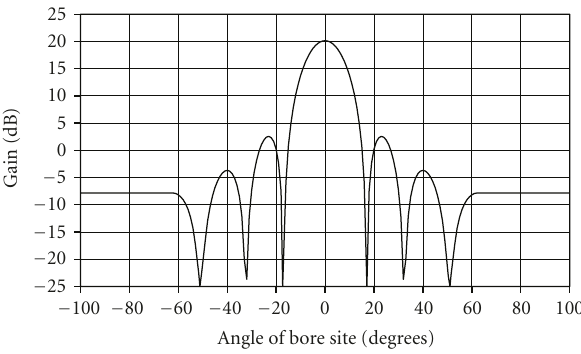
Figure 2: A directional antenna gain